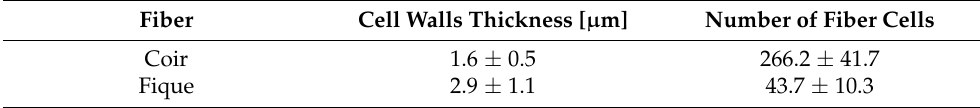
Table 2. Measurement results of cell wall thickness and the number of fiber cells.